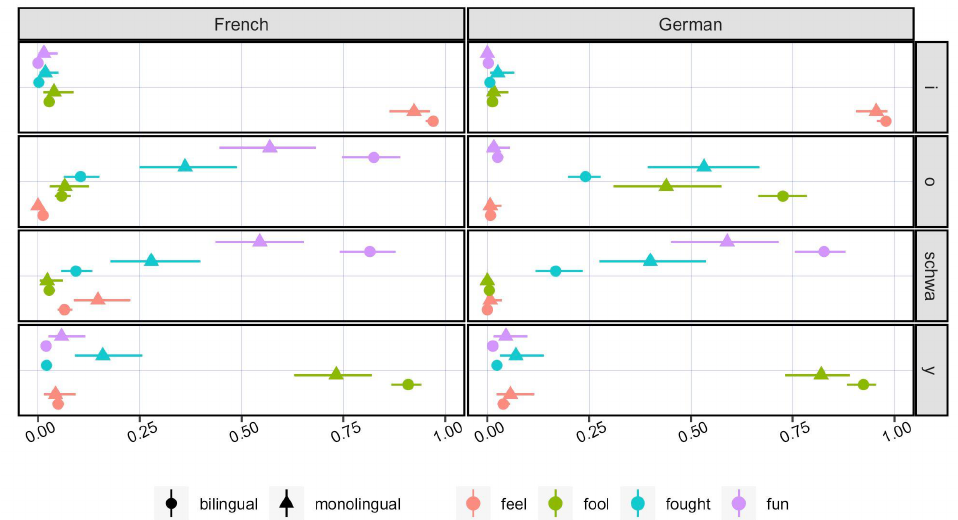
Figure 6. A comparison of the probability and conditional probability of each word choice per stimulus per language in the English monolingual group and L1 English bilingual